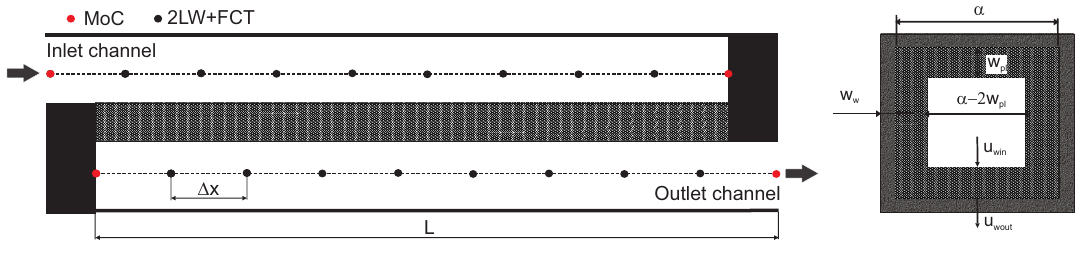
Figure 1. Scheme of the axial and cross-sections of Diesel Particulate Filter (DPF)